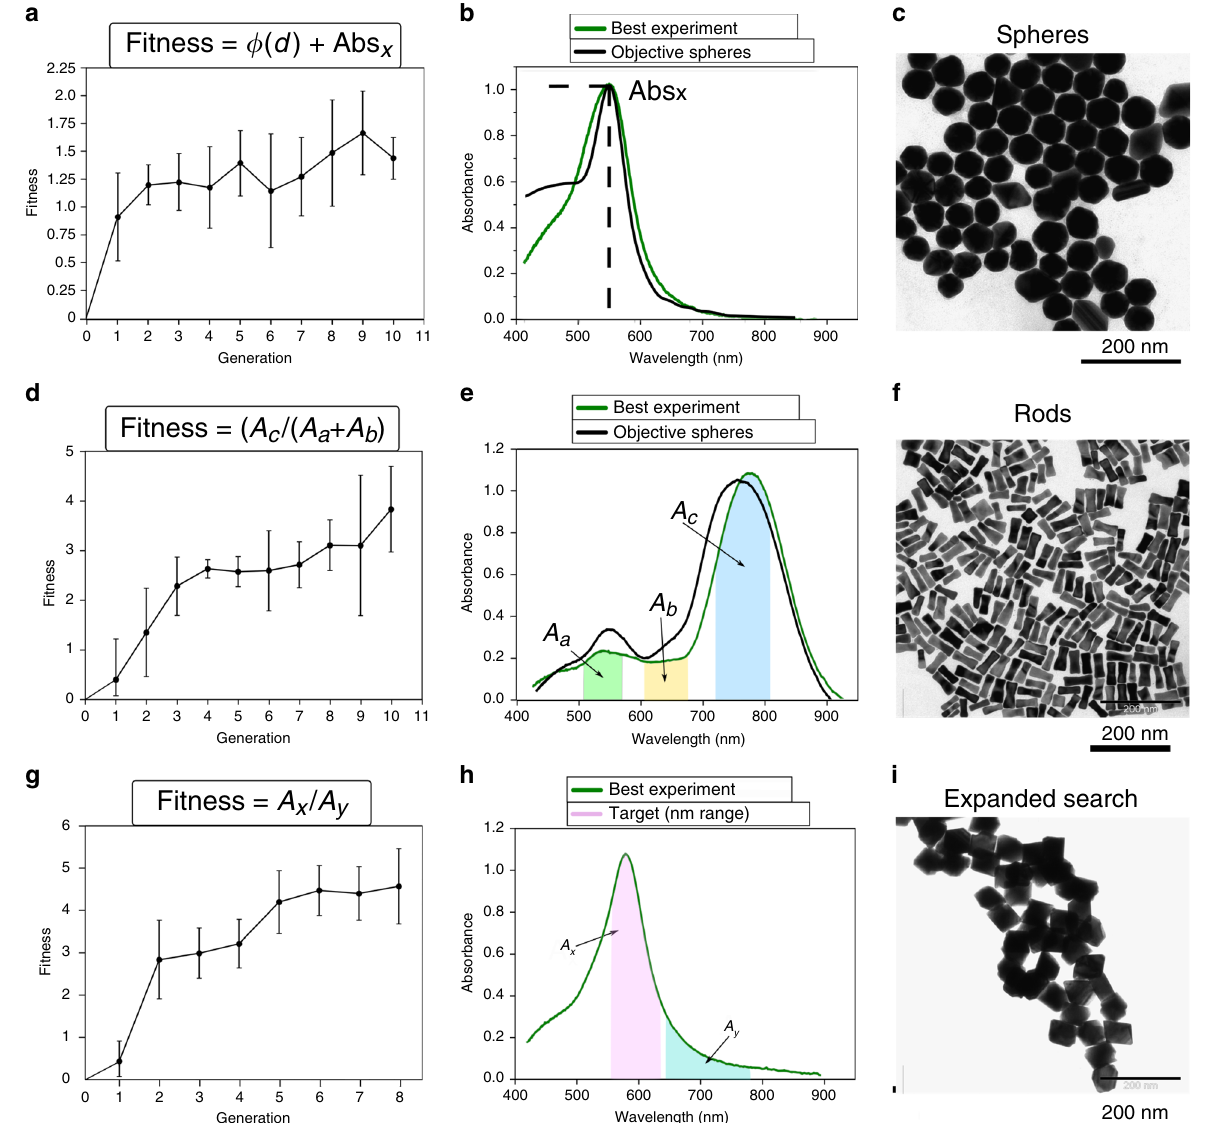
Fig. 4 Chemical spaces 1 – 3 with fi tness functions applied to several generations resulting in gold nanoparticles evolving from seeds to higher complexity particles. a Evolution of the median fi tness per generation for the nanospheres evolution. b Comparison between UV-Vis spectrum of simulated spheres from commercially available sources and the best spheres obtained with the platform. c TEM image of the ≈ 80 nm AuNSs that correspond to the UV-Vis spectrum of the best spheres obtained with the platform. d Evolution of the median fi tness per generation for the nanorods evolution. e Comparison between UV-Vis spectrum of rods described in the literature and the highest fi tness AuNR obtained with the platform. f TEM image of the AuNRs that correspond to the UV-Vis spectrum of the best nanorods obtained with the platform. g Evolution of the median fi tness per generation for the expanded search attempting to achieve a single peak at 580 nm. h Comparison between UV-Vis target peak wavelength region (pink) set by us and the spectrum with highest similarity obtained with the platform. i TEM image of the octahedral shaped gold nanorods that correspond to the highest similarity UV-Vis spectrum obtained with the platform. Error bars represent the standard deviation of the fi tness values for a given